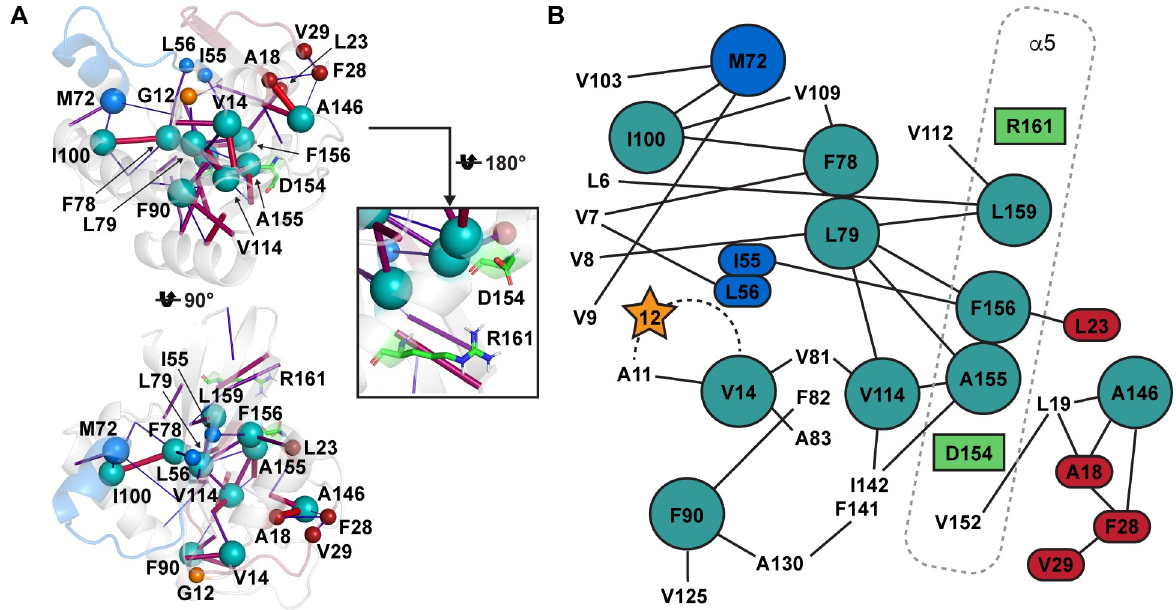
Fig 4. The hydrophobic interaction network of KRAS. The interaction network is represented for the GTP-bound wild-type KRAS ( A ), where hydrophobic hubs are displayed as large teal spheres (except for M72 depicted as blue). The hubs are defined by the criteria that each hub displays at least three hydrophobic contacts ( > 10%). The hydrophobic interactions ( > 10%) are depicted with cylinders, where the frequency of interaction is depicted in a scale from blue and thin to red and thick for low and high frequencies, respectively. The hydrophobic residues connected to the network that can influence the switch-I and switch-II dynamics are shown in small red and blue spheres, respectively. Moreover, the hub M72 is directly part of switch-II (large blue sphere). The salt-bridge forming residues D154 and R161 are displayed as green sticks. In the 2D representation of the hydrophobic hub network ( B ), the hydrophobic interactions ( > 10%) are shown with lines, and in addition to the hubs (spheres) all the hydrophobic interacting residues to the hub network are shown (in GTP-bound wild-type). The P-loop is indicated with a dashed line.